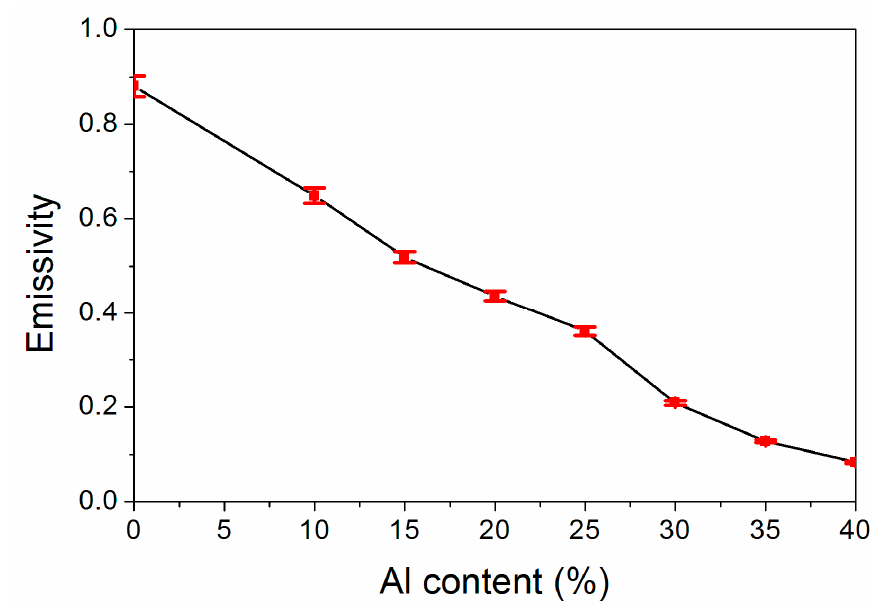
Figure 3. Influence of Al powder concentration on the coating’s infrared emissivity.